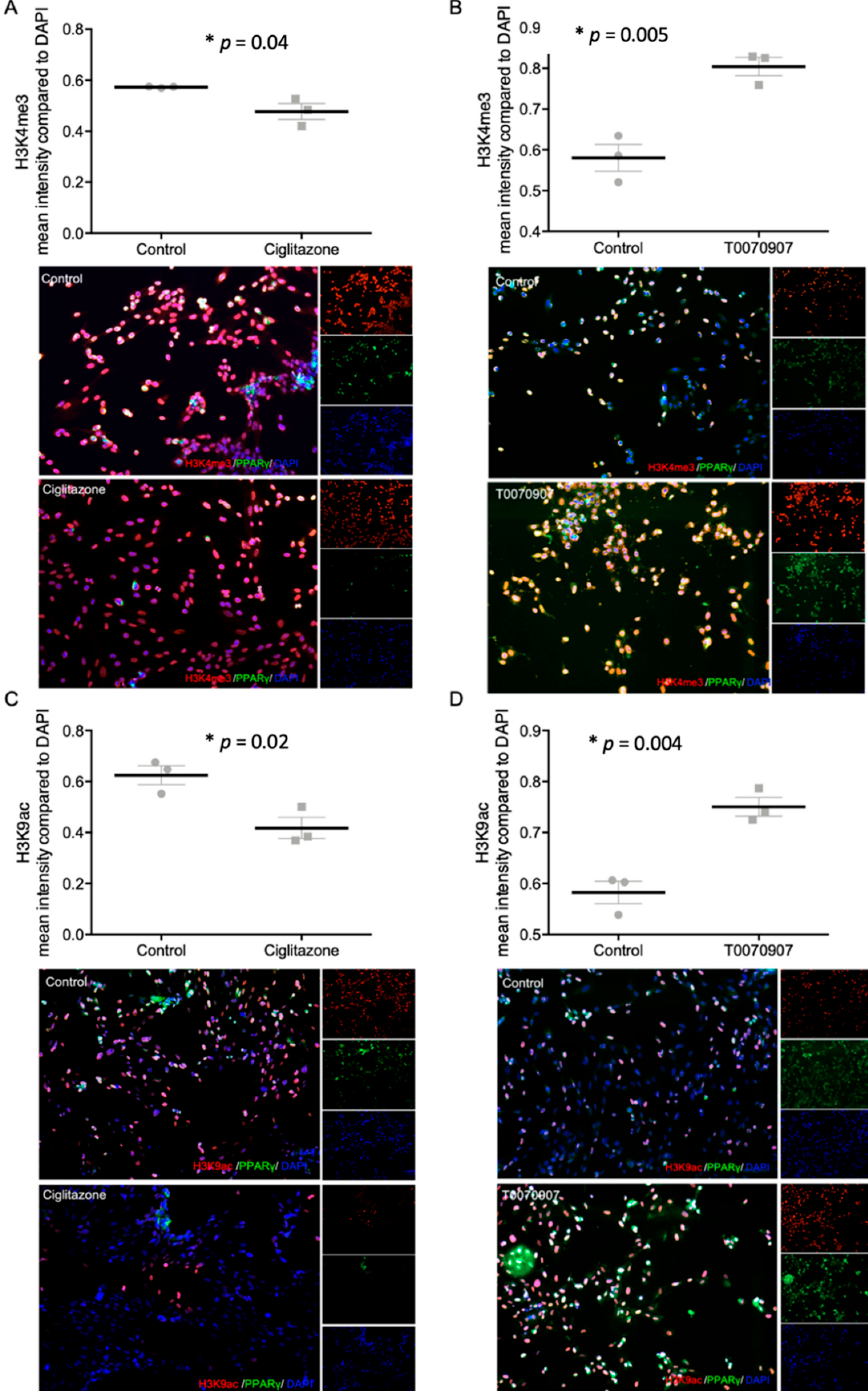
Figure 6. Staining results of histonemodifications H3K4me3 ( A , B ) and H3K9ac ( C , D ) and PPAR γ after incubation with Ciglitazone ( A , C ) (20 mM) and T0070907 ( B , D ) (50 mM) mean fluorescence intensity in relation to DAPI, with representative pictures of EVTs, histone modifications shown in red, DAPI as nucleus staining in blue; Dot plots: mean fluorescence intensity ± SEM. The respective p -value indicates, if the intensity of control cells and cells incubated with Ciglitazone or T0070907 differ significantly and was calculated using the Mann-Whitney-U-Test. Images performed with 10 × magnification, Scale bar: 50 µ